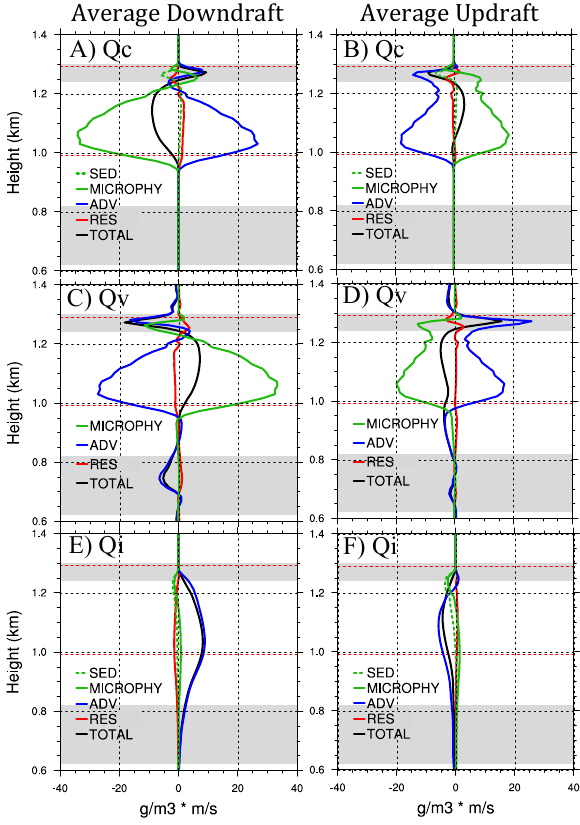
tween 0.6–1.4km averaged over downdrafts and updrafts, in units of gm − 3 day − 1 . (A) Cloud liquid water tendencies in downdrafts. (B) Cloud liquid water tendencies in updrafts. (C) Water vapor tendencies in downdrafts. (D) Water vapor tendencies in updrafts. (E) Cloud ice water tendencies in downdrafts. (F) Cloud ice wa- ter tendencies in updrafts. The contribution of sedimentation to the microphysical tendencies is shown with a green dashed line in (A) , (B) , (E) , (F) . Entrainment zones indicated with gray shading. Cloud layer top and base indicated by red dashed